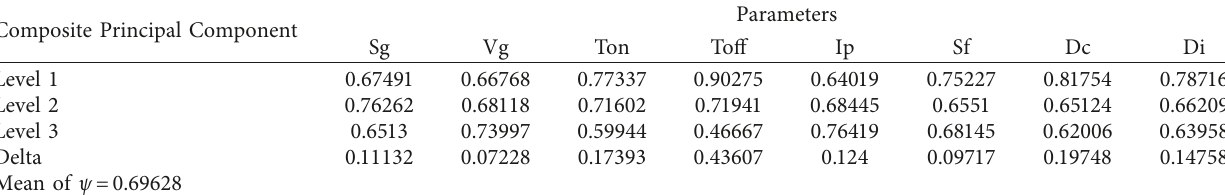
Table 16: Response table (mean) for composite principal component ( ψ ) .